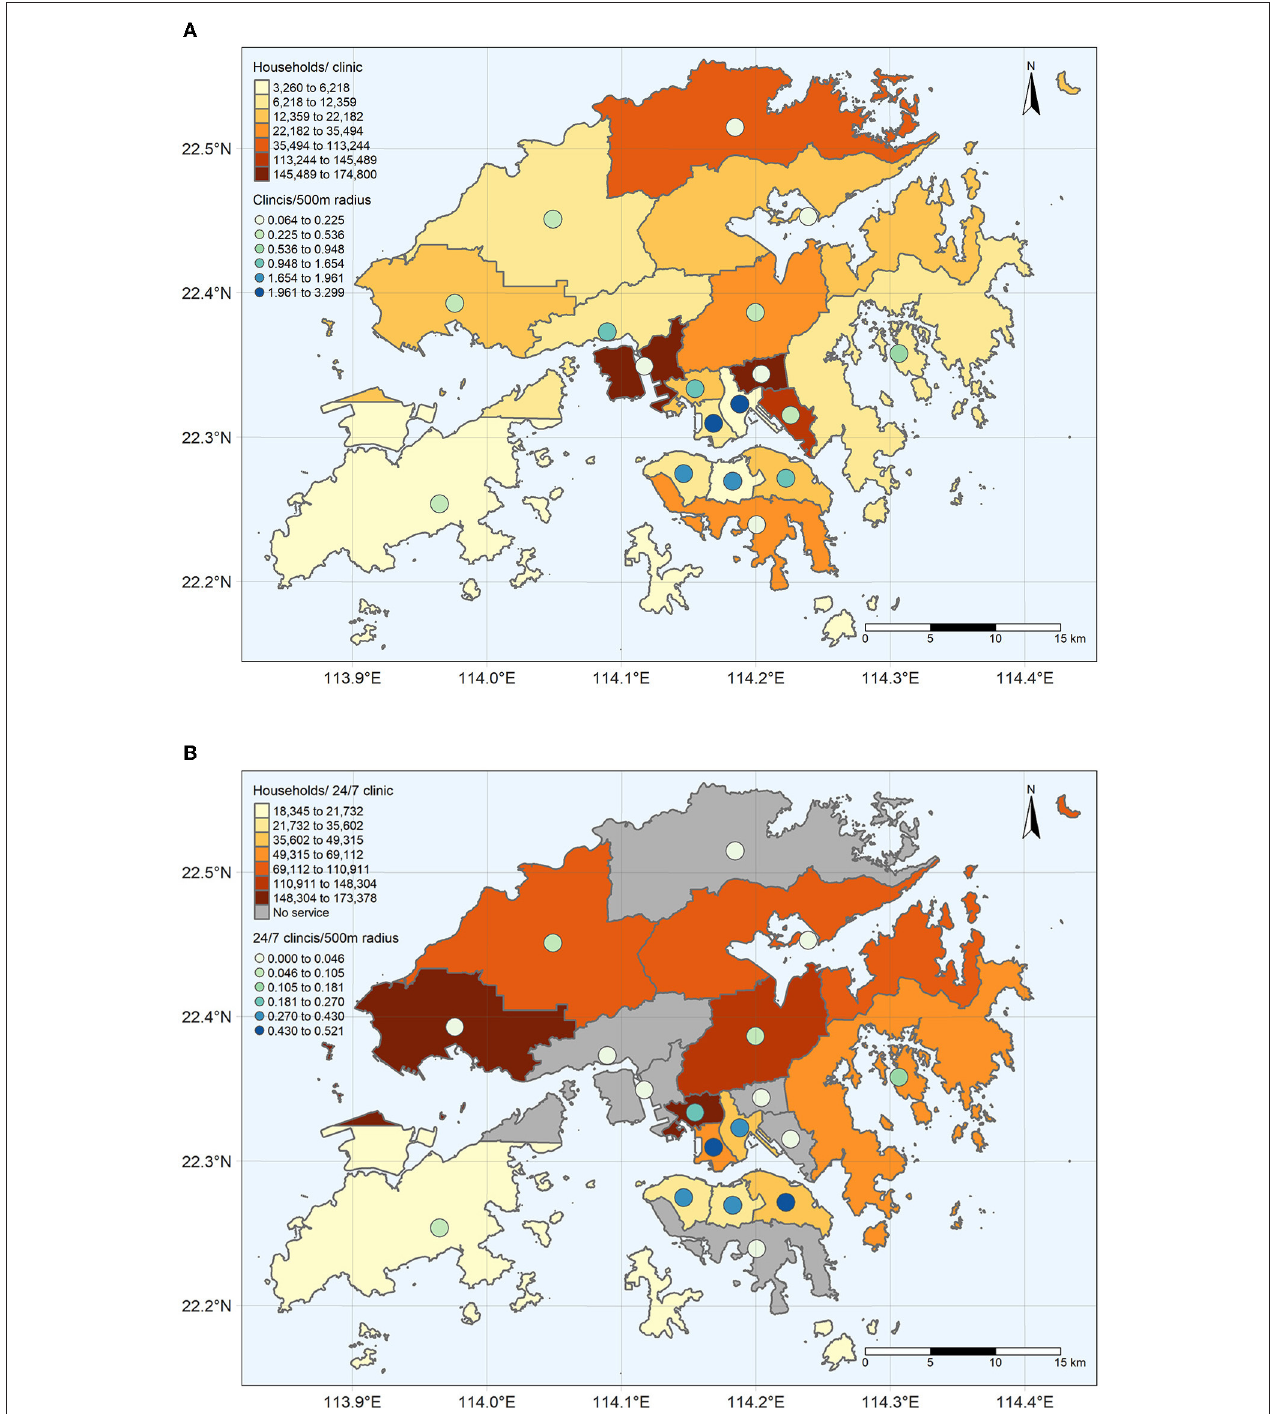
FIGURE 3 | The average number of (A) general and the (B) 24/7 vet clinics per 500m radius in residential area per district (point) superimposed on the number of households per (A) general and (B) 24/7 vet clinic for each district in Hong Kong (polygon). The Natural Breaks classification method is used to determine the interval